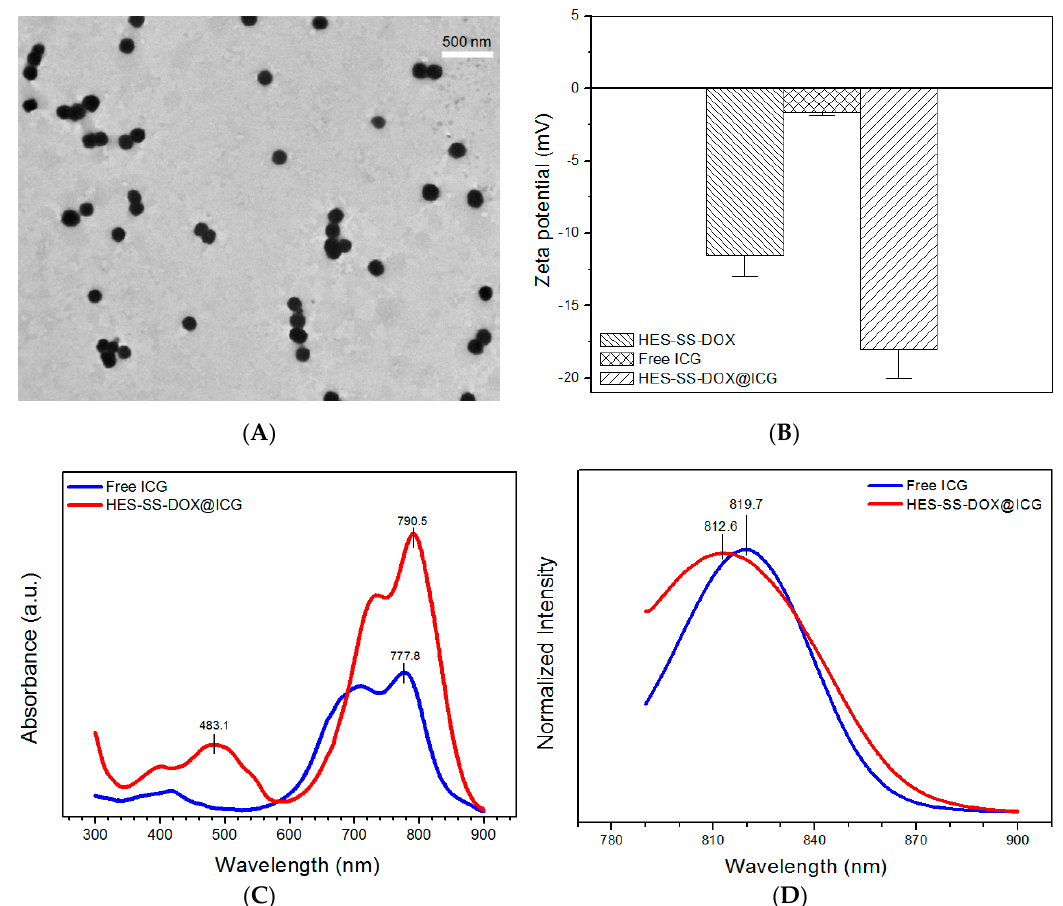
Figure 1. Typical TEM image ( A ) of HES-SS-DOX@ICG NPs, ζ potential, ( B ) UV absorbance spectra, ( C ) and fluorescence emission spectra ( D ) for different samples.